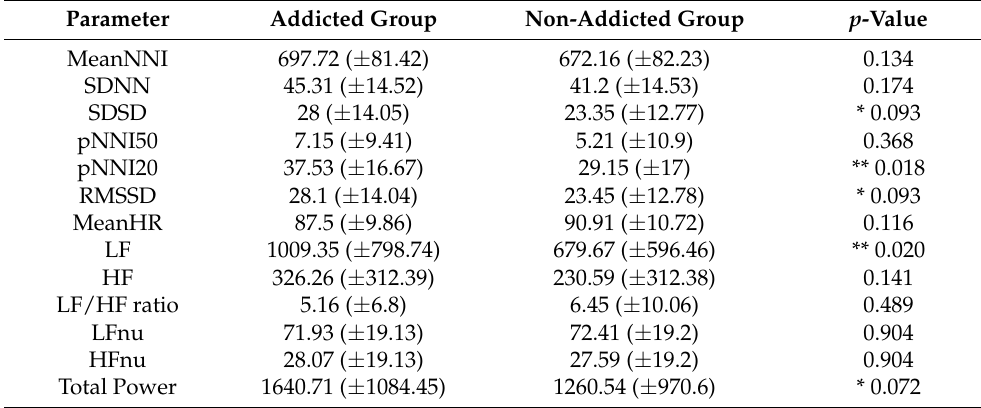
Figure 4. Factor analysis results. Table 3. The t -test results for data from 30 s window size after “killed event”; mean ( ± standard